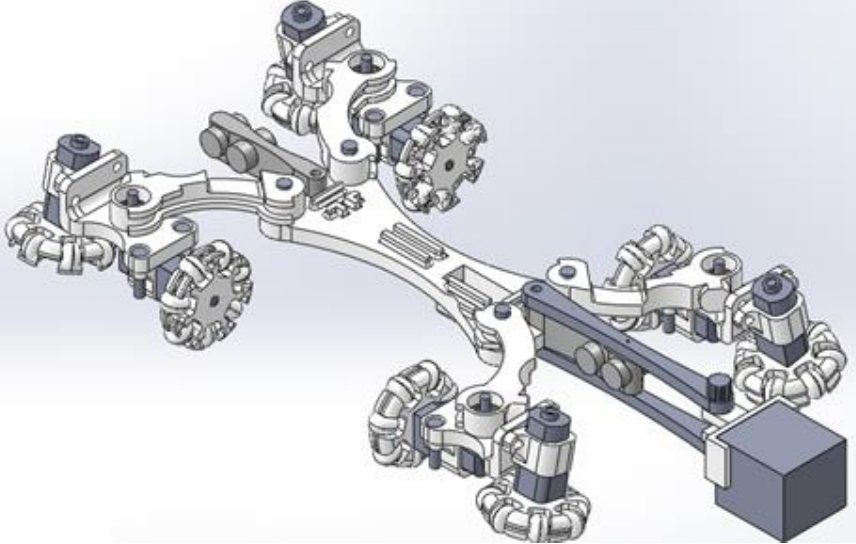
Figure 11. 3D representation of the proposed pipe robot.